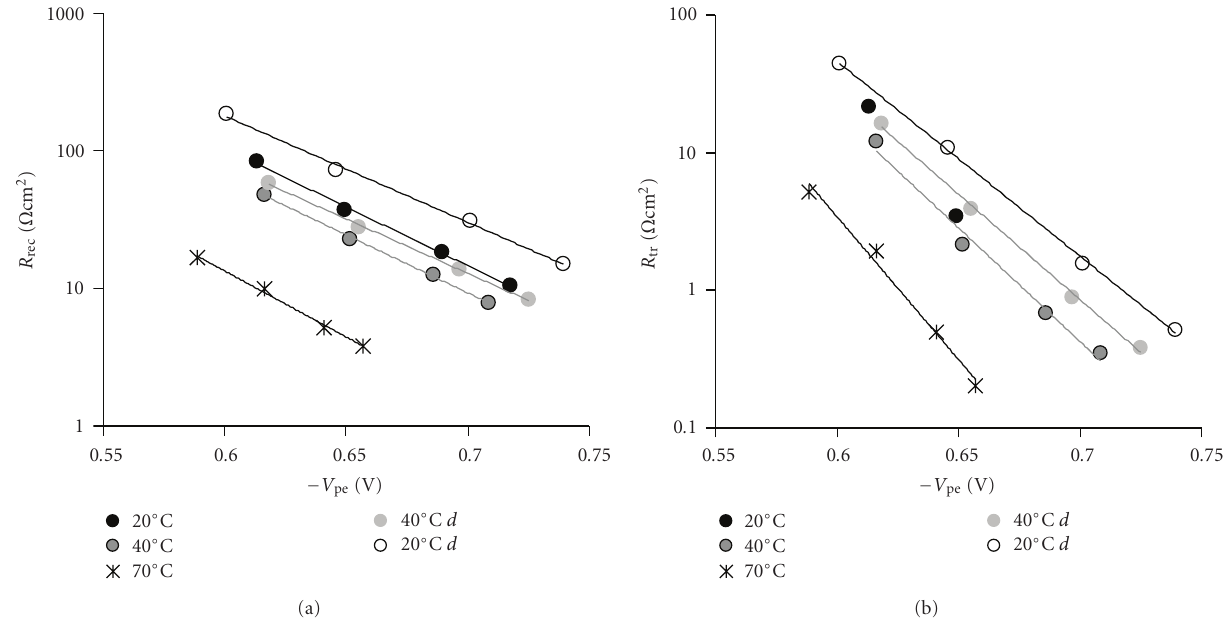
Figure 8: Recombination resistance (a) and transport resistance (b) as a function of photoelectrode voltage, at di ff erent temperatures; second set of EIS measurements. Letter “ d ” after the temperature value indicates the downward sweep of the temperature cycle.